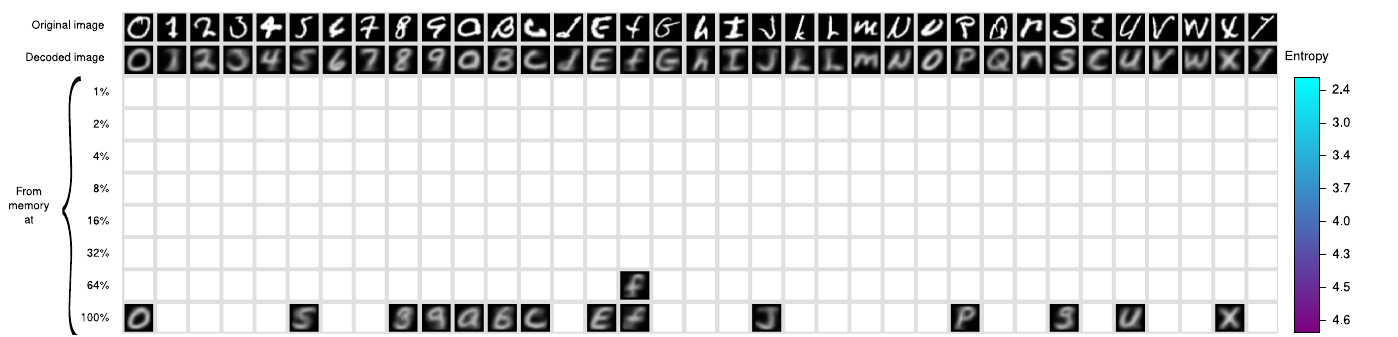
Fig 11. Poor quality cues. EMNIST-36 Symbols recovered with very poor cues as a function of the entropy.